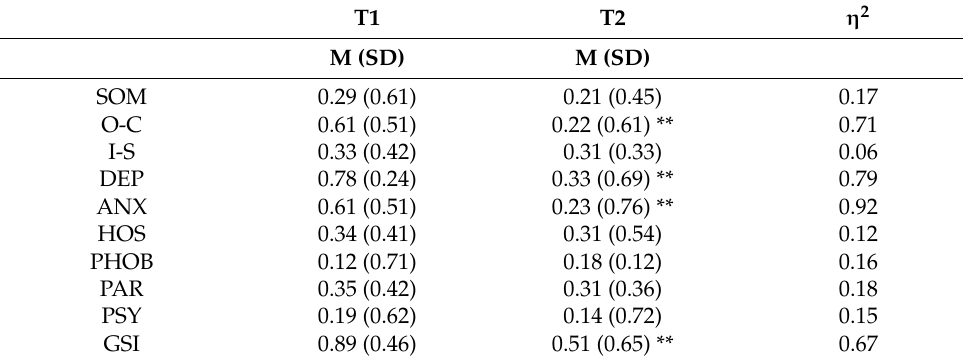
Table 2. Maternal scores at SCL-90/R.